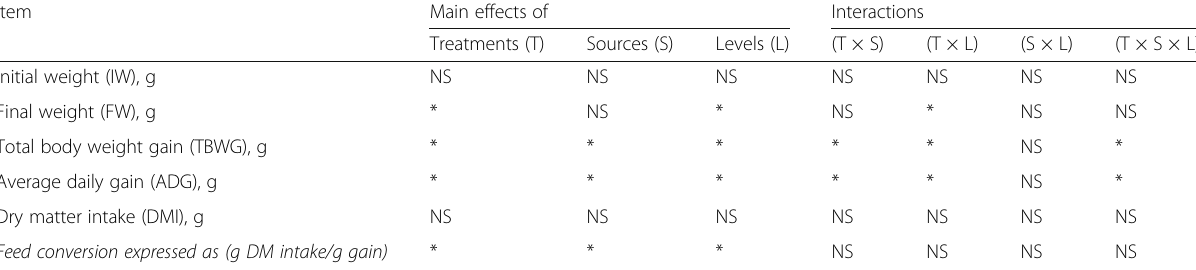
Table 6 ANOVA results of biological treatments, roughage sources, and replacement levels on growth performance of the experimental groups